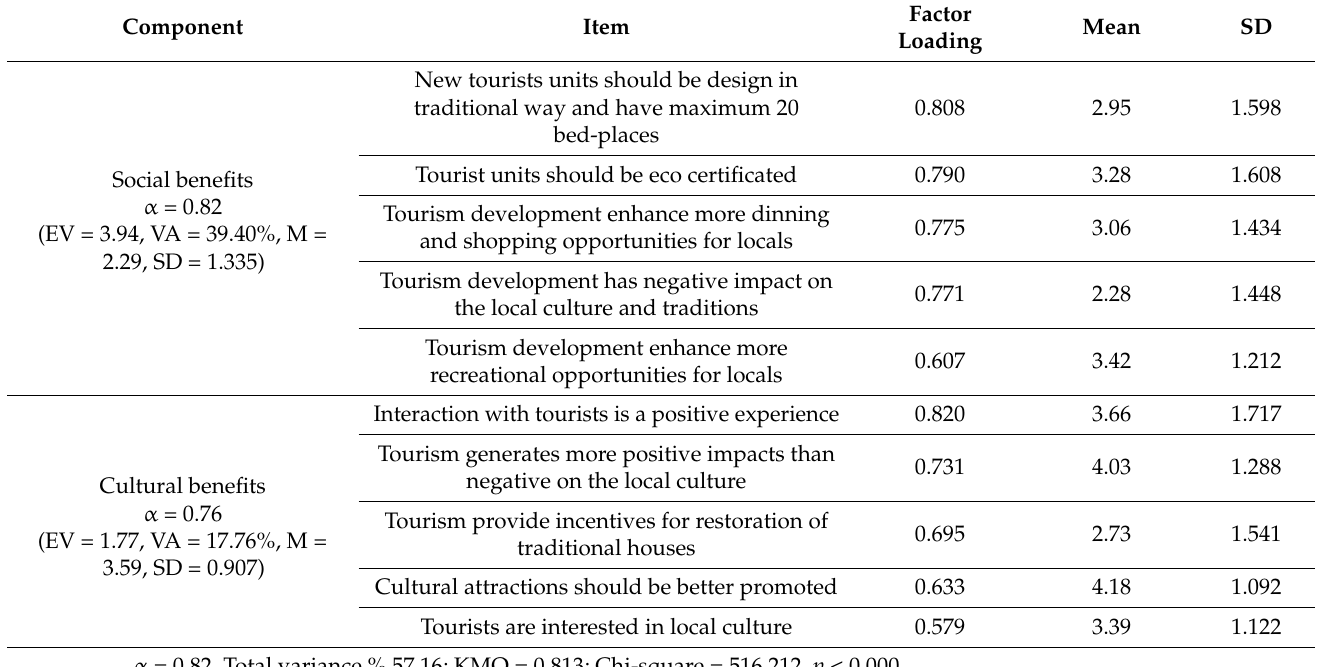
Table 3. Principal component analysis of the perceived benefits of